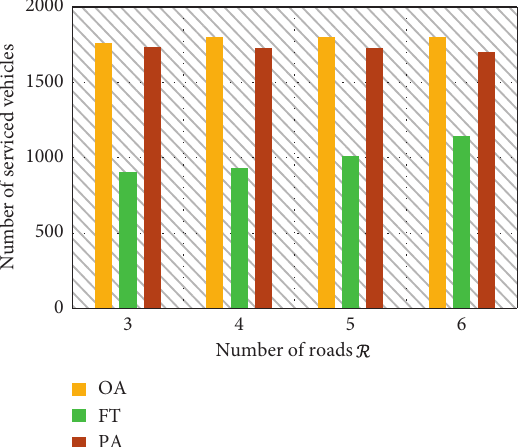
Figure 23: Effect of changing the number of roads at the inter- section (one road has a high rate and the others have a low rate) on the number of serviced vehicles using the OA, FT, and PA